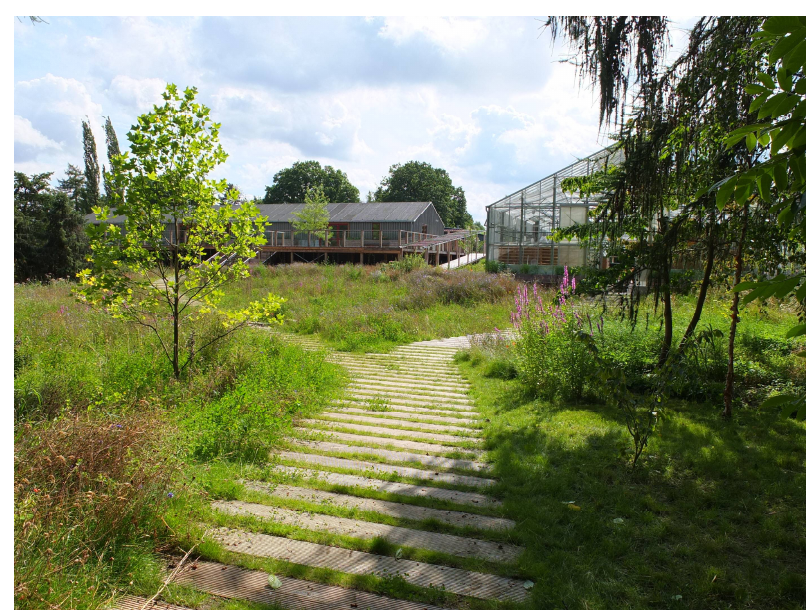
Figure 2. The picture shows a view from the therapy garden, Nacadia.